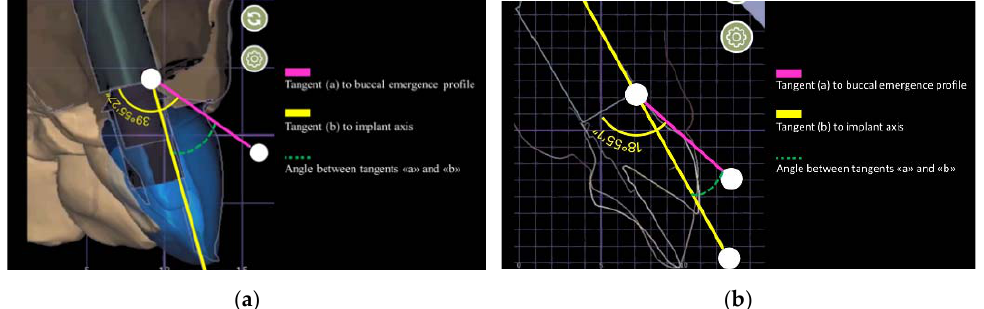
Figure 5. ( a ) Emergence angle (EA) calculation procedure. An EA score ≥ 30 degrees allocated the restoration to Group 1; ( b ) Emergence angle (EA) calculation procedure. An EA score <30 degrees allocated the restoration to Group 2.